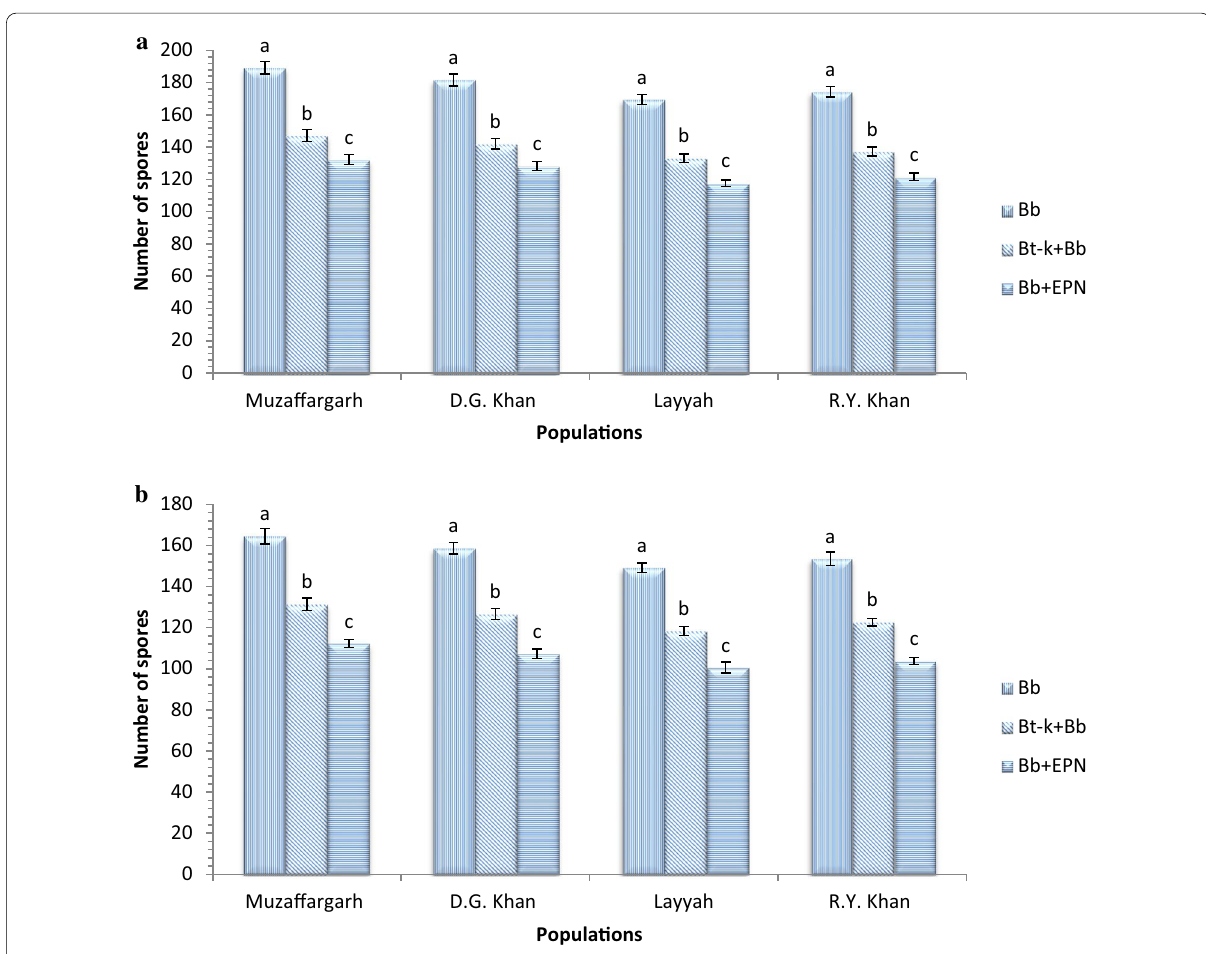
Fig. 2 a Sporulation (conidia ml − 1 ) in Rhynchophorus ferrugineus larvae treated with Bt-k (70 µg g − 1 ), Beauveria bassiana (1 and Heterorhabditis bacteriophora (300 IJs ml − 1 ) applied alone or in combination. Treatments followed by the same letter within each treatment are not significantly different; HSD test P 0.05 ( Bt-k : Bacillus thuringiensis var. kurstaki , Bb: Beauveria bassiana , EPN: Heterorhabditis bacteriophora ). ≤ b Sporulation (conidia ml − 1 ) in Rhynchophorus ferrugineus adults treated with Bt-k (70 µg g − 1 ), Beauveria bassiana (1 Heterorhabditis bacteriophora (300 IJs ml − 1 ) applied alone or in combination. Treatments followed by the same letter within each treatment are not significantly different; HSD test P 0.05 ( Bt-k : Bacillus thuringiensis var. kurstaki , Bb: Beauveria bassiana , EPN: Heterorhabditis bacteriophora ≤